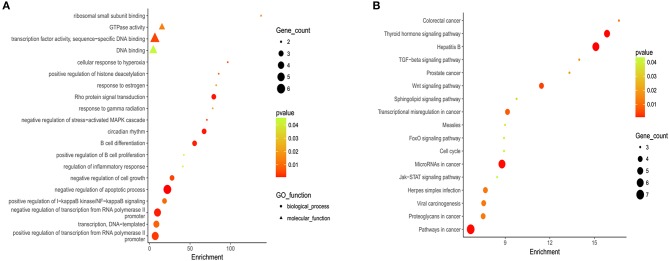
Gene ontology (GO) and Kyoto Encyclopedia of Genes and Genomes (KEGG) analysis of EBV+ DLBCL. (A) Bioinformatic analysis for the top 20 GO enrichment in EBV+ DLBCL. (B) Bioinformatic analysis for the top 15 KEGG pathway enrichment in EBV+ DLBCL. (The P-value denoted the significance of GO terms enrichment in the genes and was adjusted by using Benjamini and Hochberg method to avoid false positives, and P < 0.05 was considered as significantly enriched).